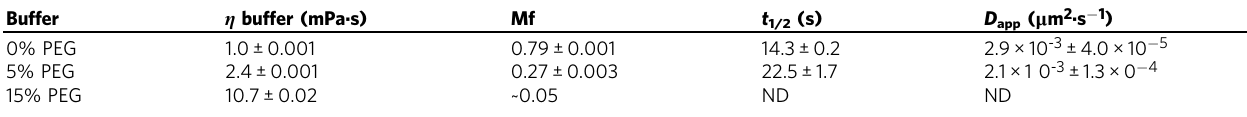
Table 1 FRAP fraction recovery and half recovery times of NPM1 in NPM1-S6N droplets with and without crowding agent Buffer